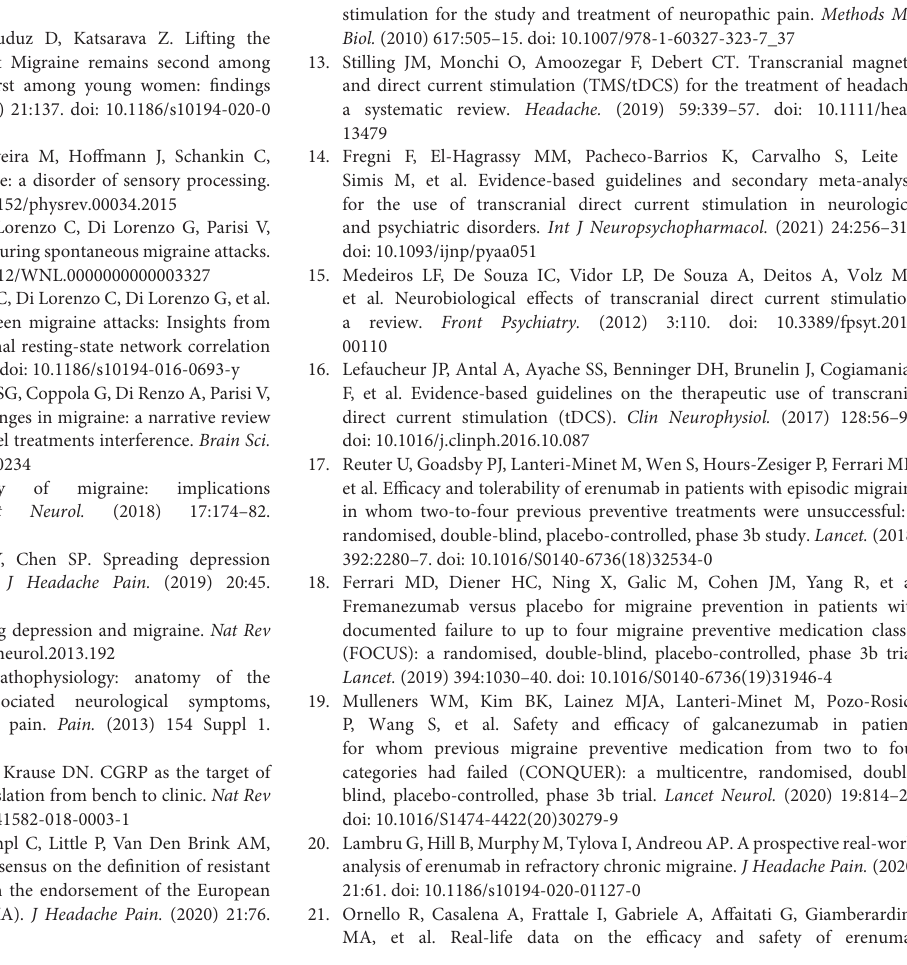
Figure 1 was created with pictures from Servier